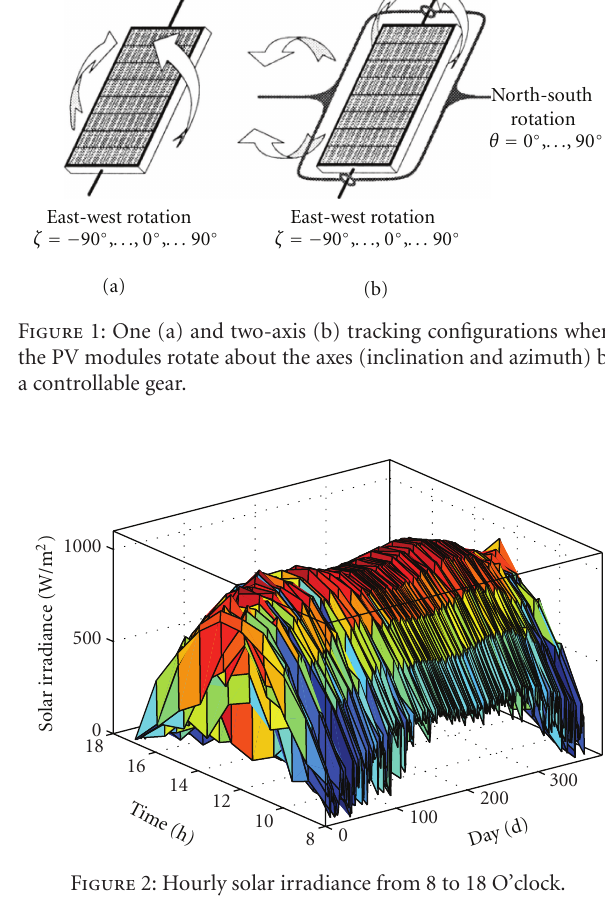
Figure 2: Hourly solar irradiance from 8 to 18 O’clock.